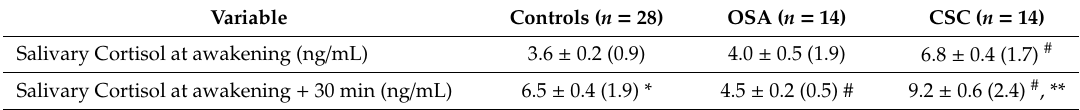
Table 2. Salivary cortisol awake response (CAR) in the study populations.